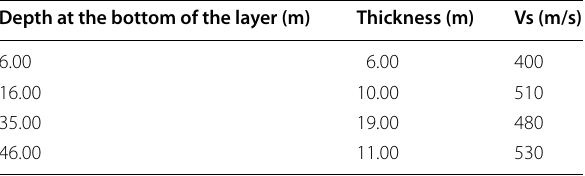
Table 3 Results of MASW at Mansadevi landslide, Harid‑ war Depth at the bottom of the layer